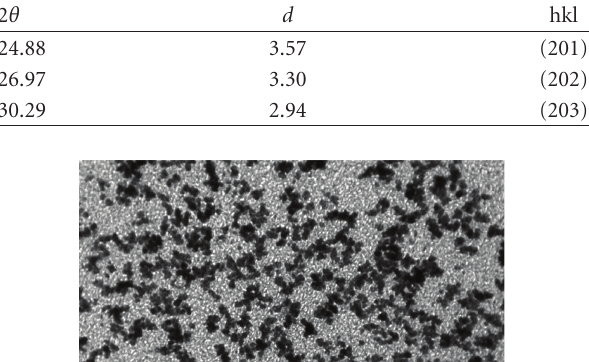
Table 1: X-ray for PTCDI films.